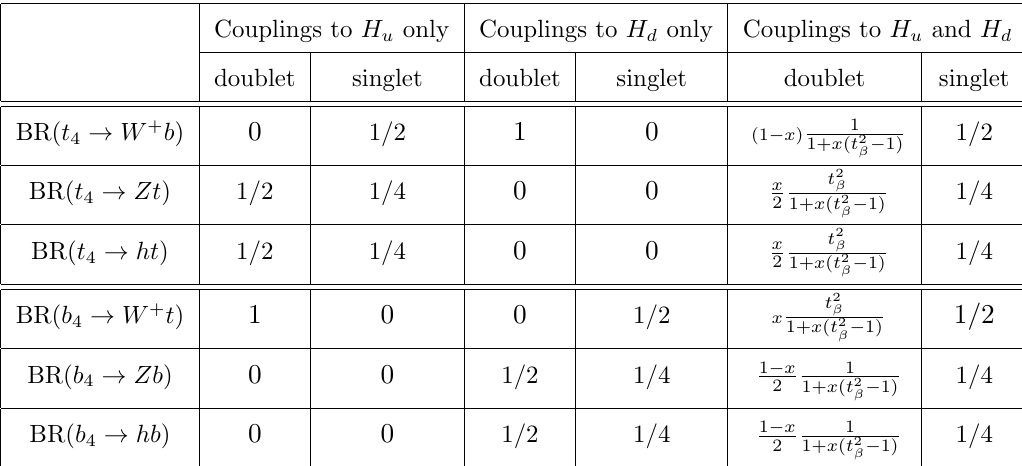
Table 3 . Vectorlike quark branching ratios in the Goldstone boson equivalence limit. When couplings to both H u and H d are present the branching ratios are functions of t (cid:12) = tan (cid:12) and x = (cid:20) 2 = ( (cid:20) 2 + (cid:21) 2 Q Q Q